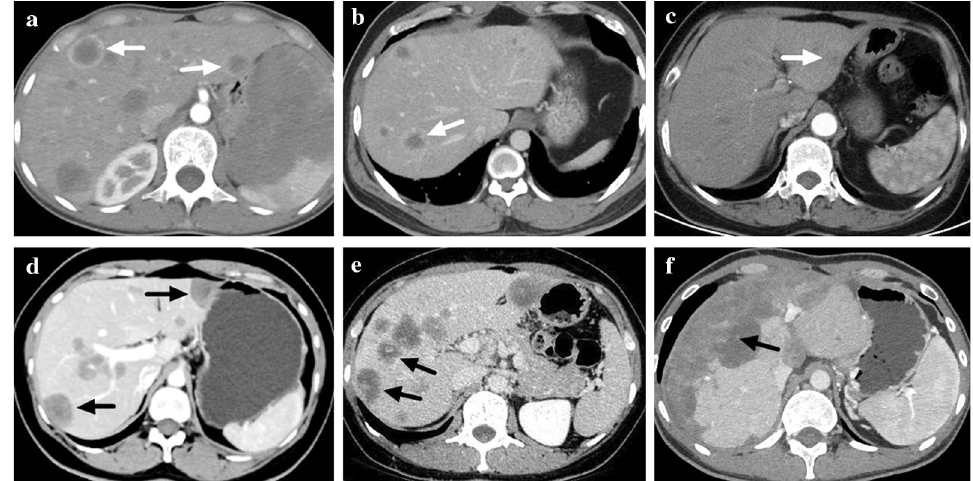
Fig. 4 Enhancement patterns of HEH lesions on contrast-enhanced CT scan. a Ring-like enhancement on arterial phase (marked with white arrows). b Ring-like enhancement on portal phase (marked with a white arrow). c Target-like enhancement on arterial phase (marked with a white arrow). d Target-like enhancement on portal phase (marked with black arrows). e Core enhancement on portal phase (marked with black arrows). f Heterogenous enhancement on portal phase (marked with a black